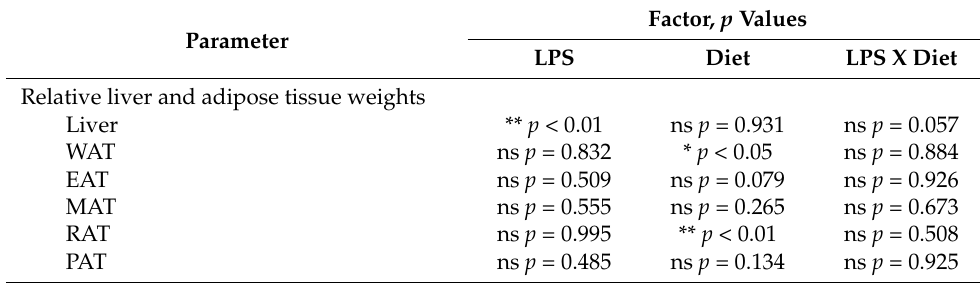
Table 4. Statistical results of the two-way ANOVA for the effect of LPS and diet and LPS X diet interaction. Parameter Relative liver and adipose tissue